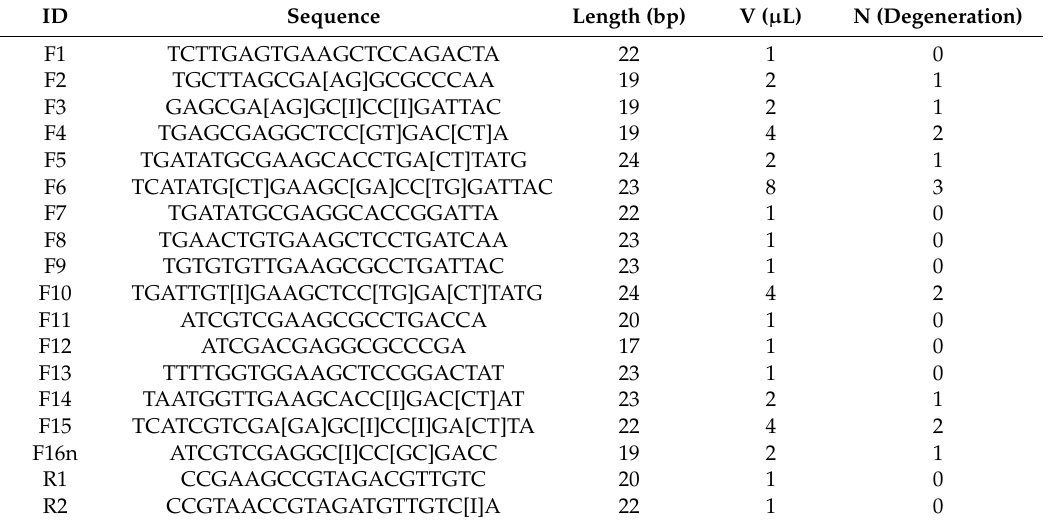
Table 2. Summary of primers to amplify glycoside hydrolases of family 48 (GH48) gene